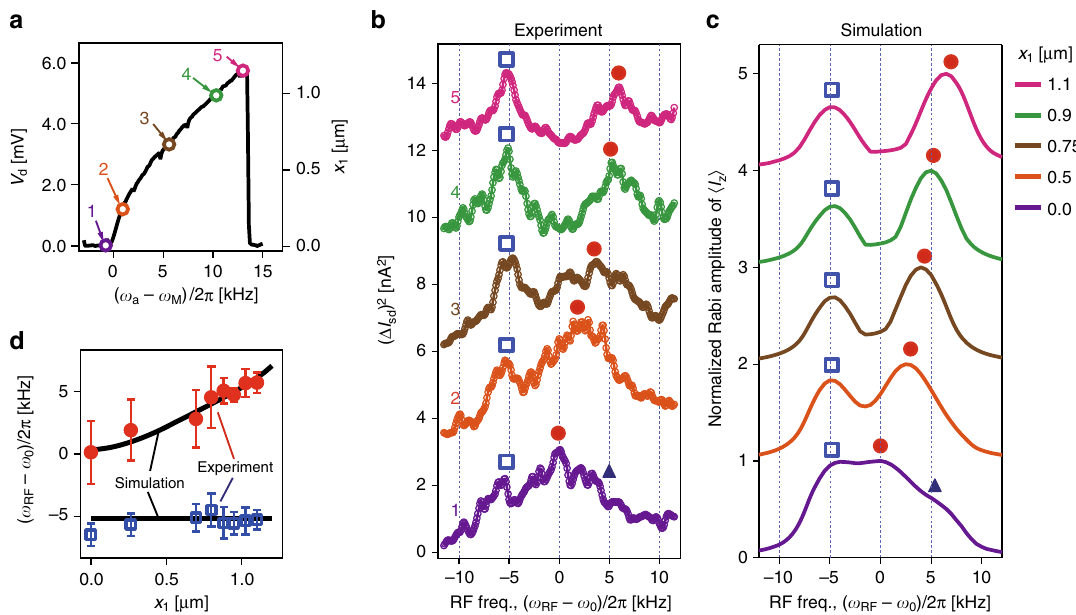
Fig. 3 NMR frequency shift induced by a driven electromechanical strain. a A plot of the mechanical amplitude x 1 with stronger actuation: V a = 40 mV. b NMR spectra for 75 As nuclei at B 0 = 3.1 T under intense mechanical oscillations as a function of ω RF with ω 0 /2 π = 22.606 MHz. From bottom to top, the spectra are measured at ( ω a − ω M )/2 π = − 0.3, 1.0, 6.3, 10.8, and 13.0 kHz with a fi xed actuation V a = 40 mV as indicated by the colored open circles in a . c The numerical simulation of the NMR spectra which shows the normalized oscillation amplitude of 〈 I z 〉 for x 1 = 0, 0.5, 0.75, 0.9, 1.1 μ m from bottom to top, respectively. d A plot of the measured NMR peak frequency as a function of x 1 , where the open square (solid circle) symbol corresponds to the left (center) peak in b determined from the Lorenz fi t to the spectra. The error bars correspond to the peak width determined from the fi tting. The solid lines show the theoretical frequency shift derived from the numerical